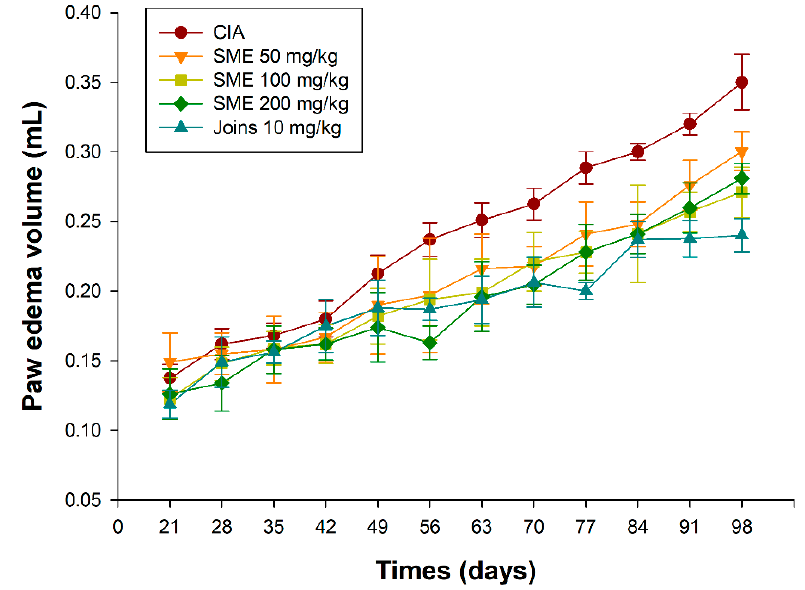
Figure 2. Effects of the Sargassum muticum extract on paw edema. CIA, collagen-induced arthritis vehicle control group; SME 50 mg/kg, group provided with 50 mg/kg of S. muticum extract; SME 100 mg/kg, group provided with 100 mg/kg of S. muticum extract; SME 200 mg/kg, group provided with 200 mg/kg of S. muticum extract; Joins 10 mg/kg, positive control.